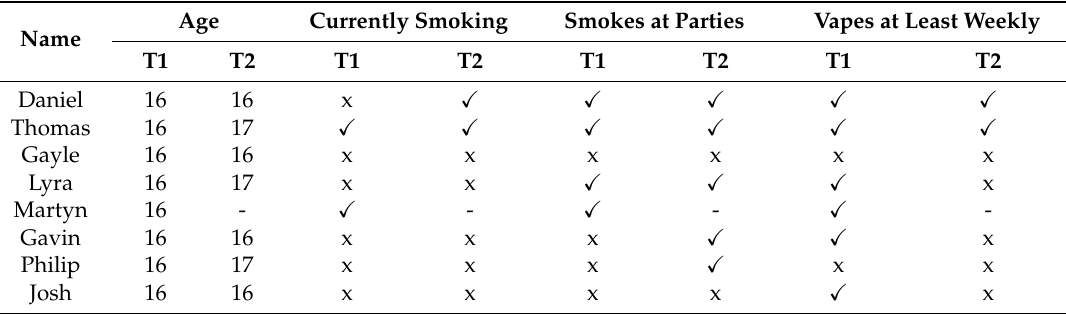
Table 1. Reported change in vaping and smoking at six months (Time =